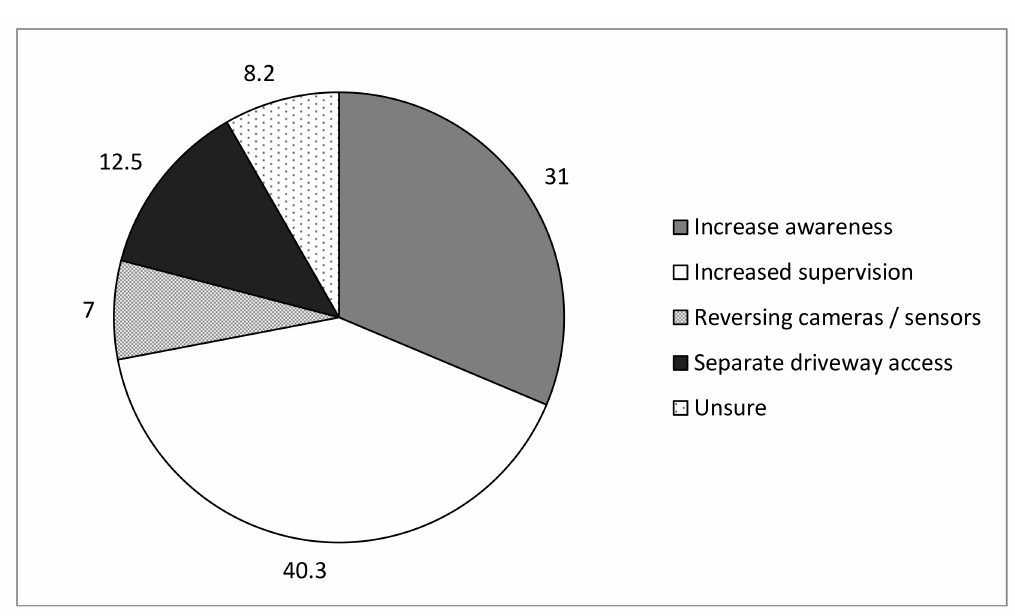
Figure 2. Strategies suggested by respondents for reducing LSVRO incidents (%).